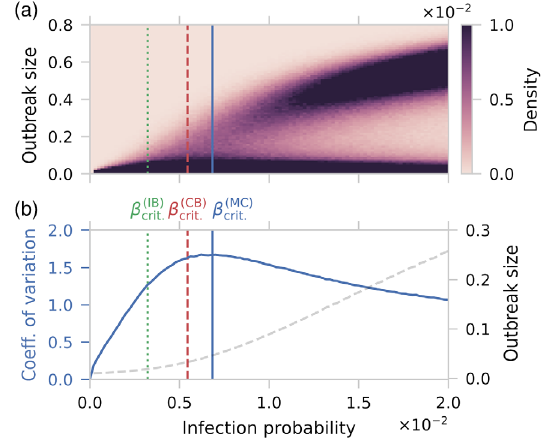
FIG. 6. Estimation of the critical infection probability β . crit (a) Outbreak-size distribution as in Fig. 4 for small values of β . The vertical blue, red dashed, and green dotted lines mark the critical value according to MC simulations ( β ð MC Þ ), the CB model crit ( β ð CB Þ ), and the IB approach ( β ð IB Þ ), respectively. (b) From the crit crit distribution in (a), we derive the coefficient of variation (blue line, left axis) and the mean outbreak size (grey dashed line, right